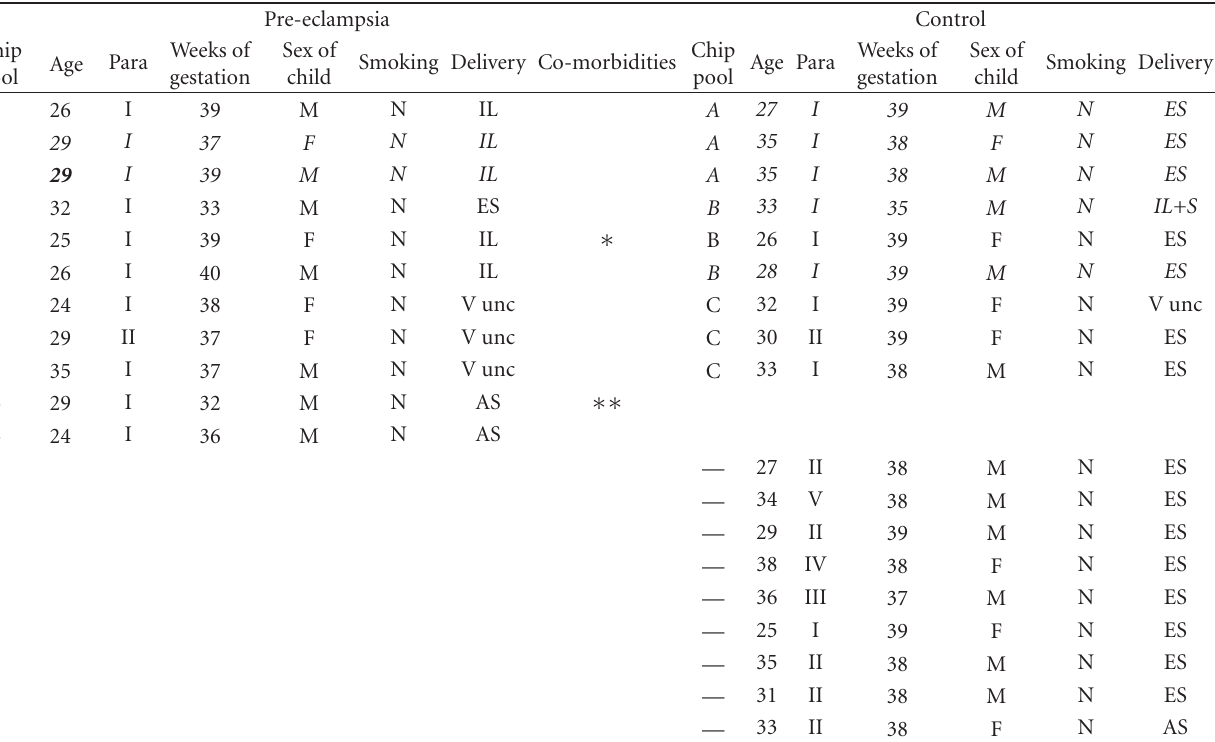
Table 1: Clinical data on the included women and